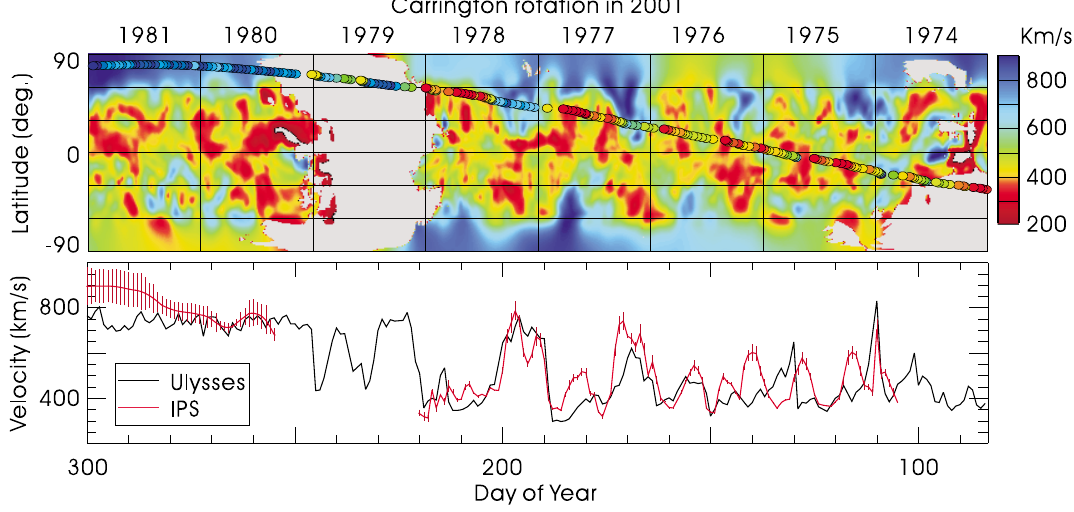
Fig. 3. Comparison between IPS and Ulysses observations. Velocity map in Carrington rotations from 1974 to 1981 are estimated from IPS observation. Coloured circle plots show Ulysses data which is traced back to 2.5 R s . The colour scale for the circle plots are same as the background image (upper figure). Velocity observed by IPS along the Ulysses trajectory is compared in the lower panel. Red and black lines shows IPS and Ulysses